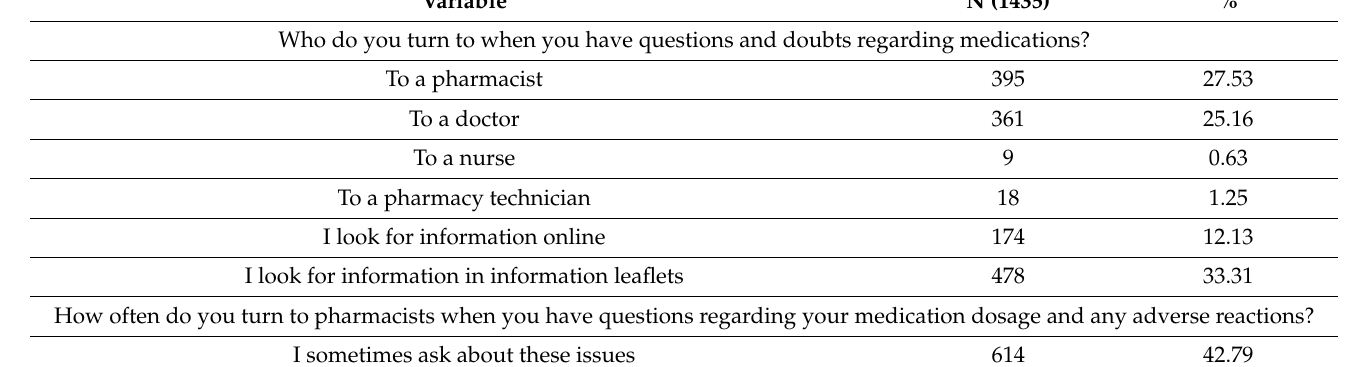
Table 3. Evaluation of pharmaceutical consultations and the level of patient satisfaction with phar- macy